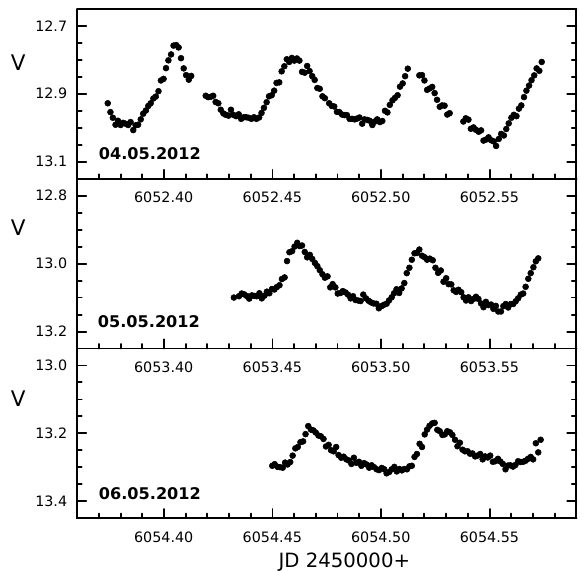
Figure 1: V844 Her light curves obtained at the begin- ning of the outburst. Decreasing of superhumps which is clearly seen on the light curve at the bottom indicates that a new stage is approaching.